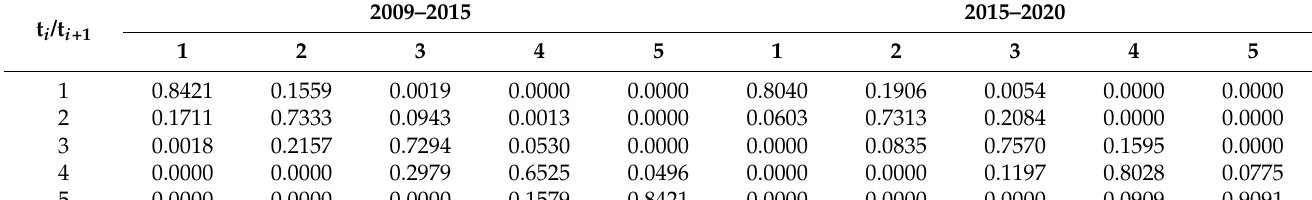
Table 3. Markov chain transitional matrix of PIR in China.